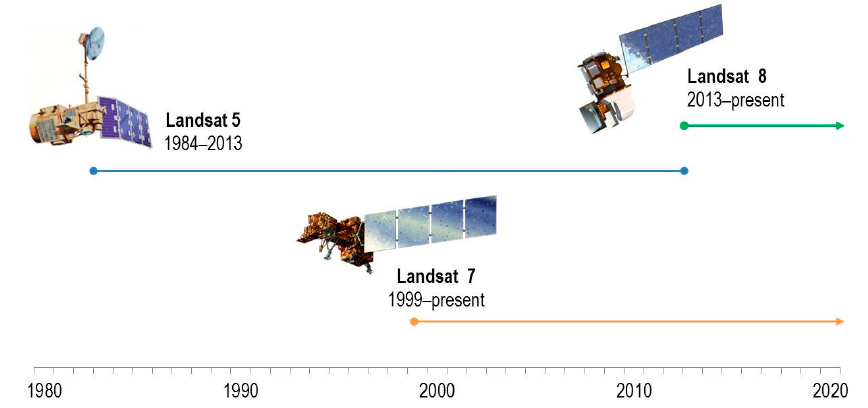
Figure 2. Timeline of Landsat mission operations. Source: https://landsat.gsfc.nasa.gov/ . Table 2. Available Landsat images (5490 total) with corresponding sediment data for the Upper Mississippi River study